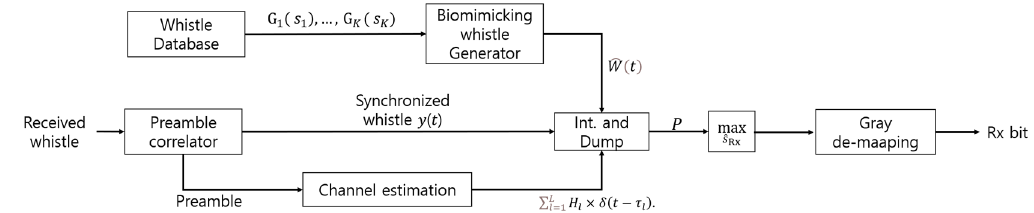
Figure 7. Block diagram of the proposed biomimicking demodulation.